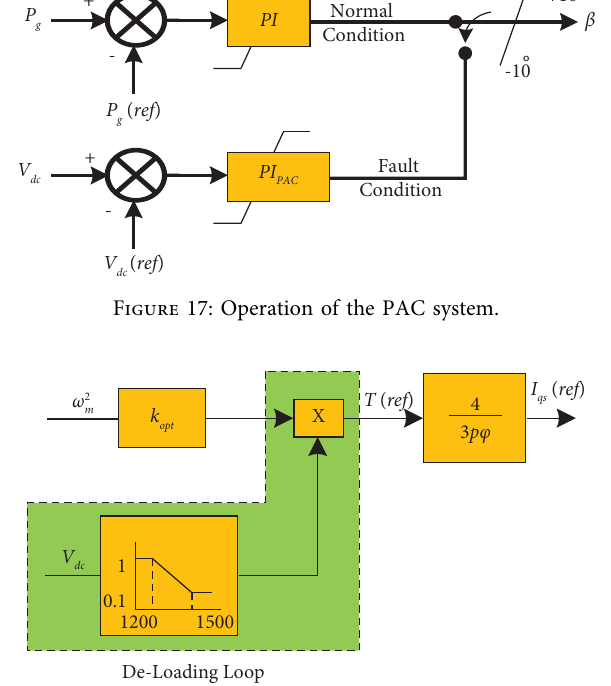
Figure 18: Te deloading scheme.